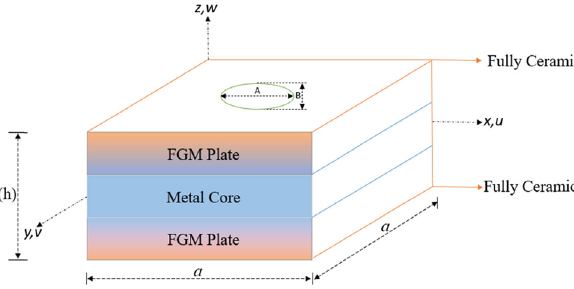
Figure 1: Geometry and coordinates of FGM sandwich plate with elliptical cutout.